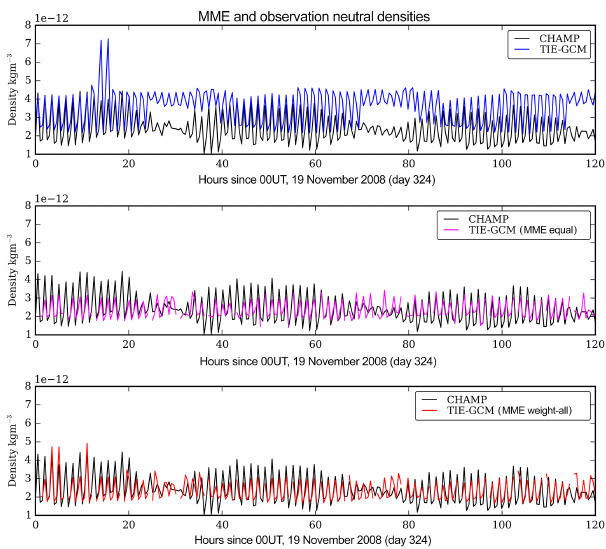
Figure 20. Top panel shows the neutral density from the CHAMP observations and the original TIE-GCM run. The subsequent pan- els then show the CHAMP observations with each of the new TIE- GCM outputs using the MMEs as the initial conditions every